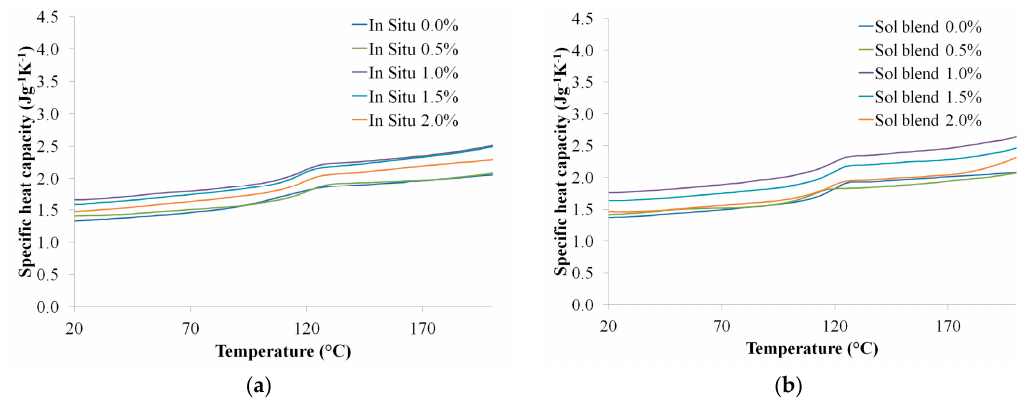
Figure 16. Specific heat capacity of the neat PMMA and RGO/PMMA nanocomposites prepared by ( a ) in situ polymerization and ( b ) solution blending.